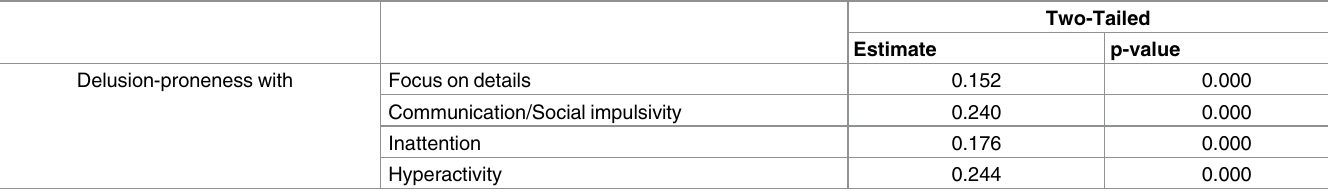
Table 3. Significant correlations between the PDI-factor and four factors from the 7-factor model analysis (full